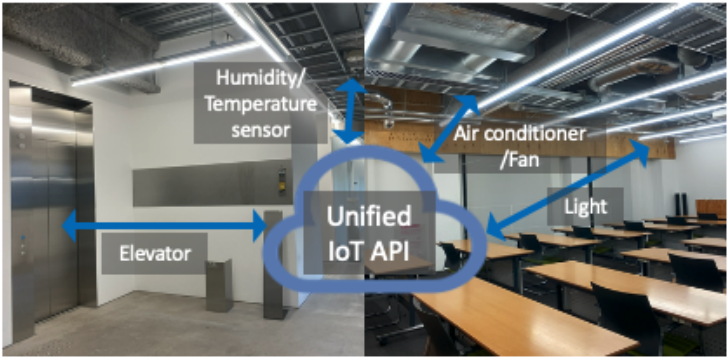
Figure 10. The IoT-enabled smart building environment.